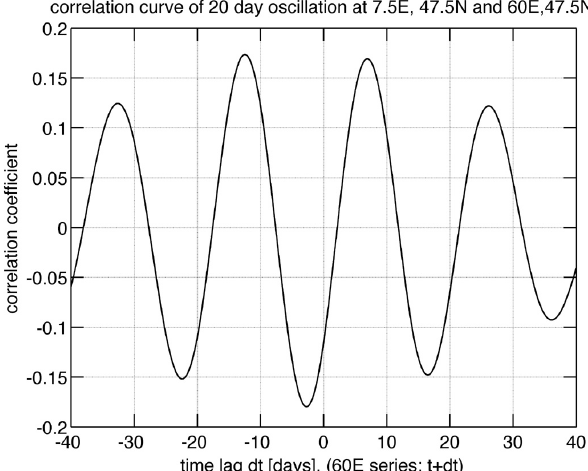
Fig. 4. The correlation curve of the filtered 20-day ozone oscilla- tions (7hPa, 1979 to 2010) at 7.5 ◦ E, 47.5 ◦ N and 60 ◦ E, 47.5 ◦ N only shows a weak anti-correlation. Generally the 20-day oscilla- tion is not coherent at both